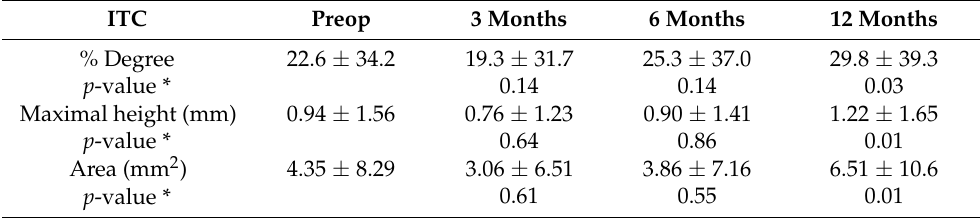
Table 1. Time course alteration in ITC indices.